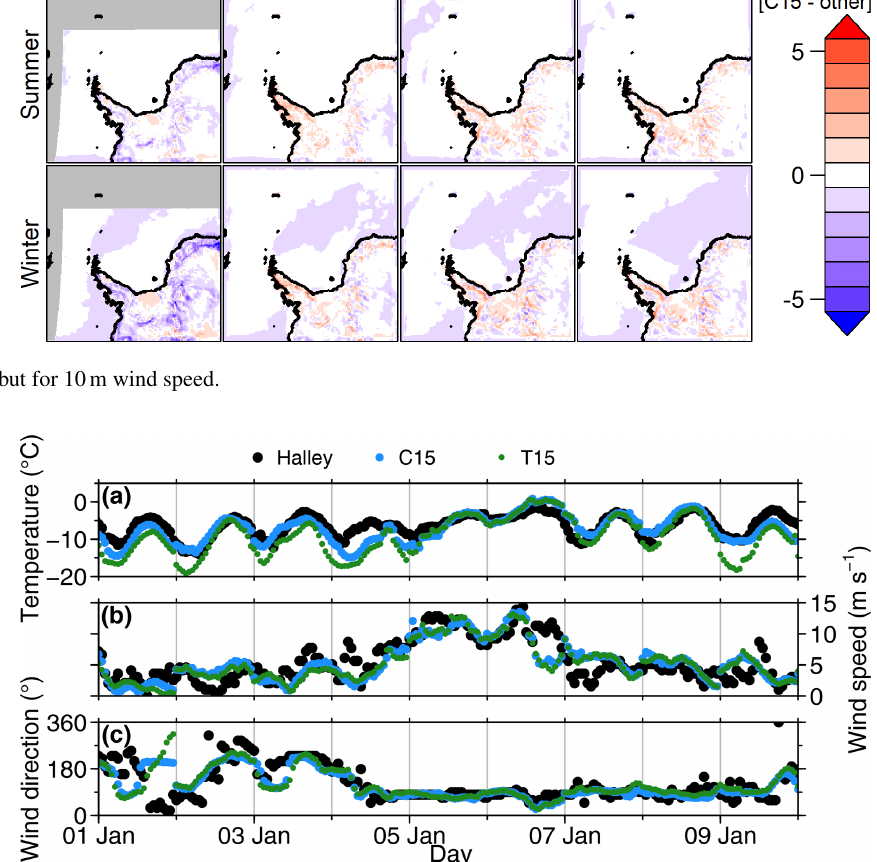
Figure 6. Comparison for Halley of (a) 2m temperature, (b) 10m wind speed, and (c) 10m wind direction for station measurements (black), C15 (blue), and T15 (green) during January 2016. Vertical grey lines indicate the restart of the daily